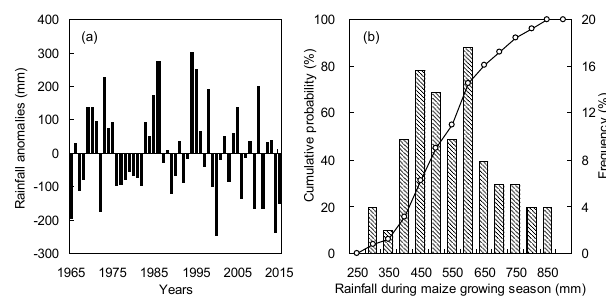
Figure 2. Anomalies and cumulative frequency of rainfall during the maize-growing season (May to September) from 1965 to 2015 at Shengyang,